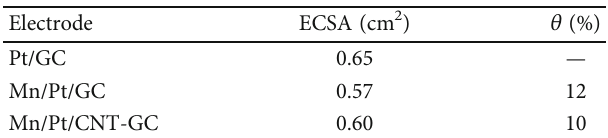
Table 1: Summary of the electrochemical data extracted from Figure